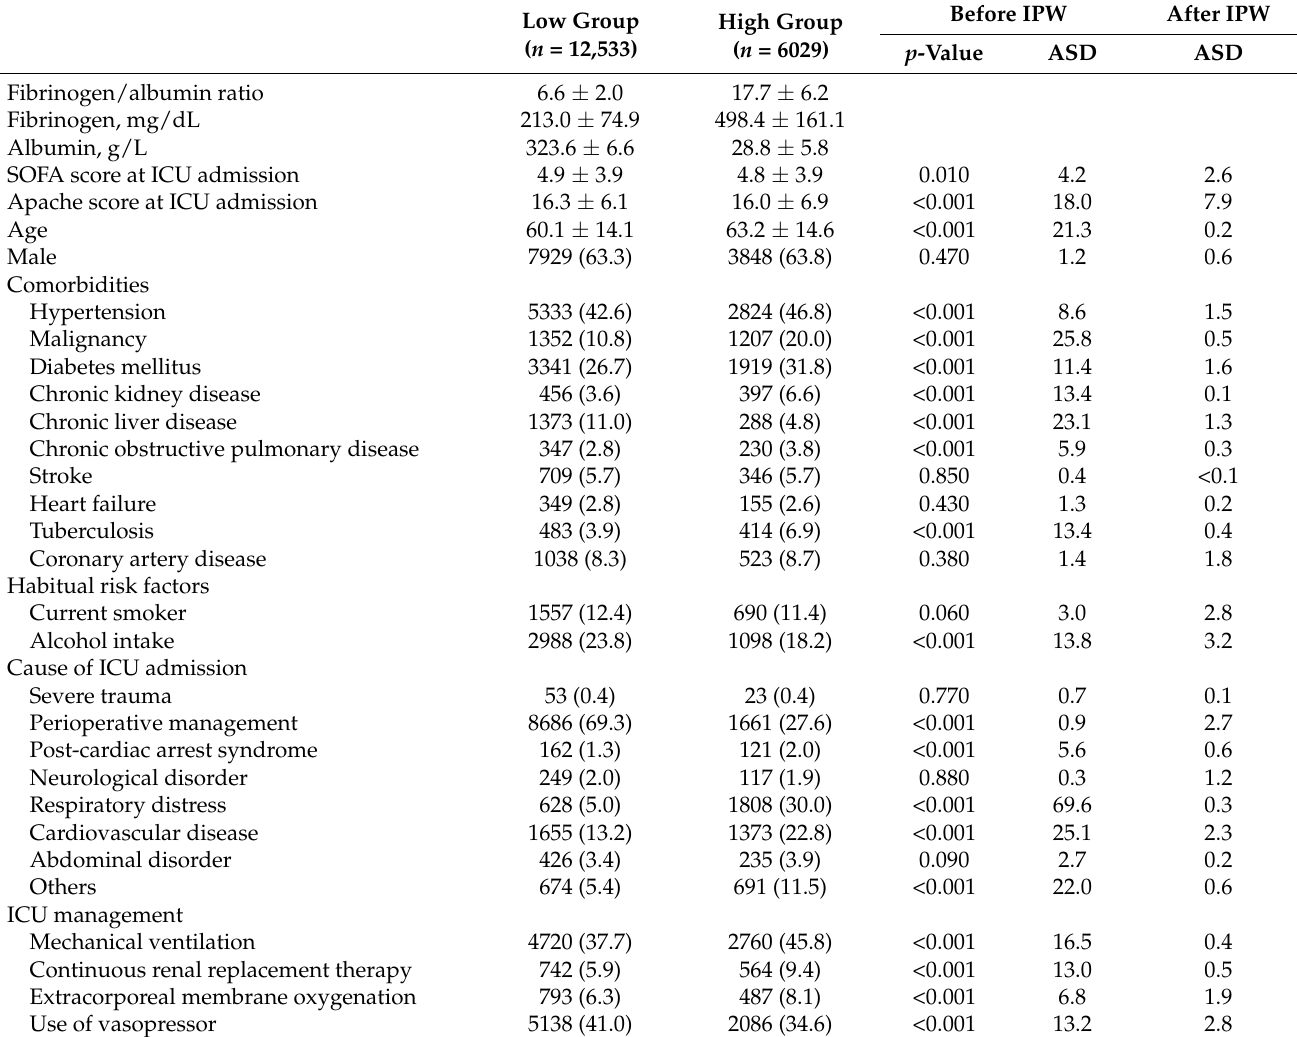
Table 2. Baseline characteristics according to the estimated threshold of fibrinogen/albumin ratio of 10.79. Before IPW After IPW Low Group High Group ( n = 12,533) ( n = 6029)